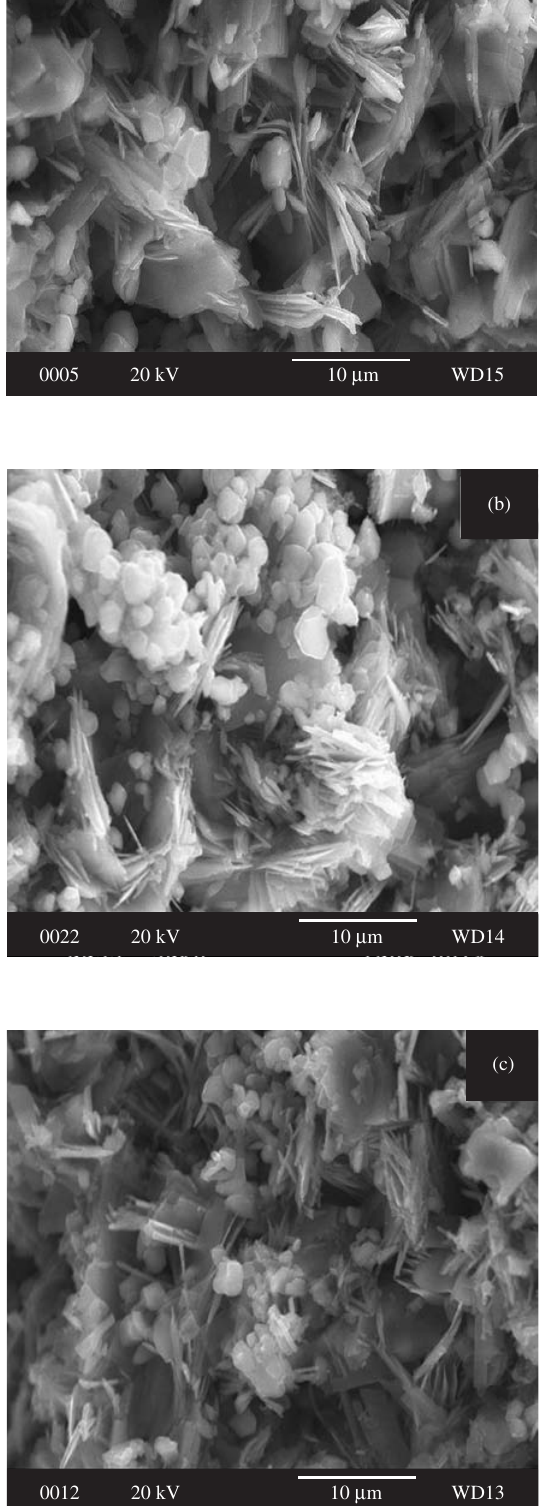
Figure 2. SEM micrographs of the fracture surface after sterilization. a) EtO; b) AC; and c)